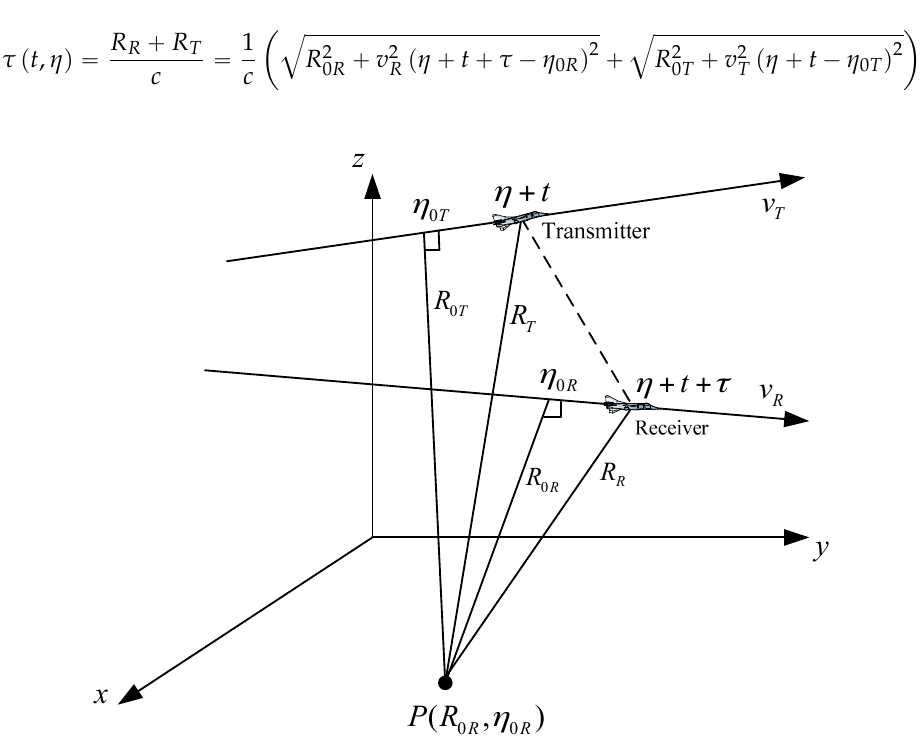
Figure 2. Geometry of bistatic frequency modulated continuous wave (FMCW) synthetic aperture radar (SAR).